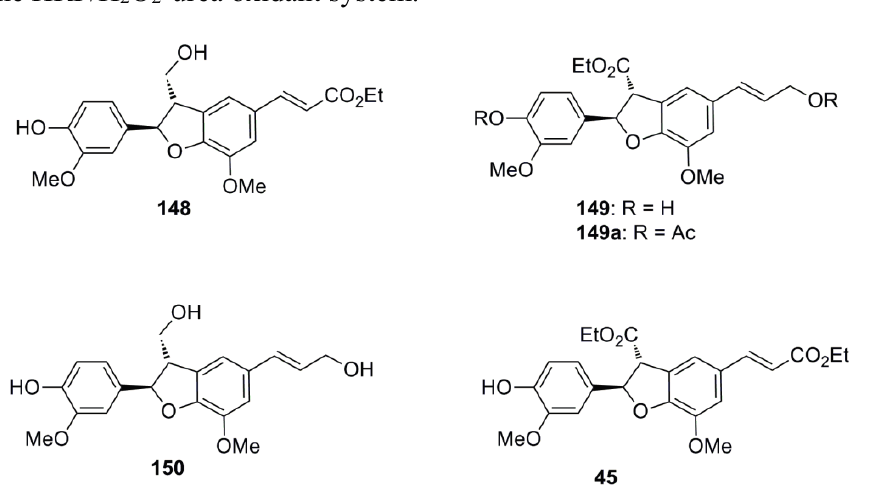
Figure 6. Cross- and homo-coupled products from the cross-POC of Et-Fer with ConAl utilizing the HRP/H 2 O 2 -urea oxidant